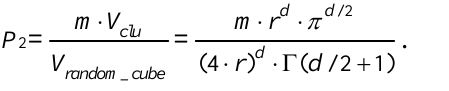
Fig. 1. The rectangles are random value ranges , the cycles are clusters and the shadows are regions covered by detectors. From the higher cluster level to the lower level, the cluster radius is